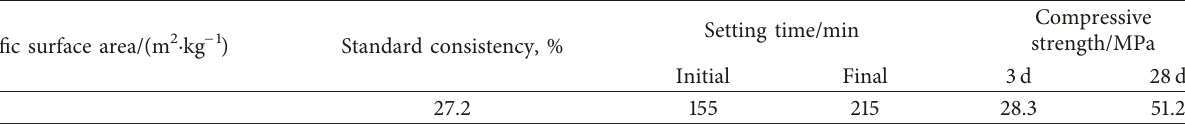
Table 2: The physical properties of cement test results.